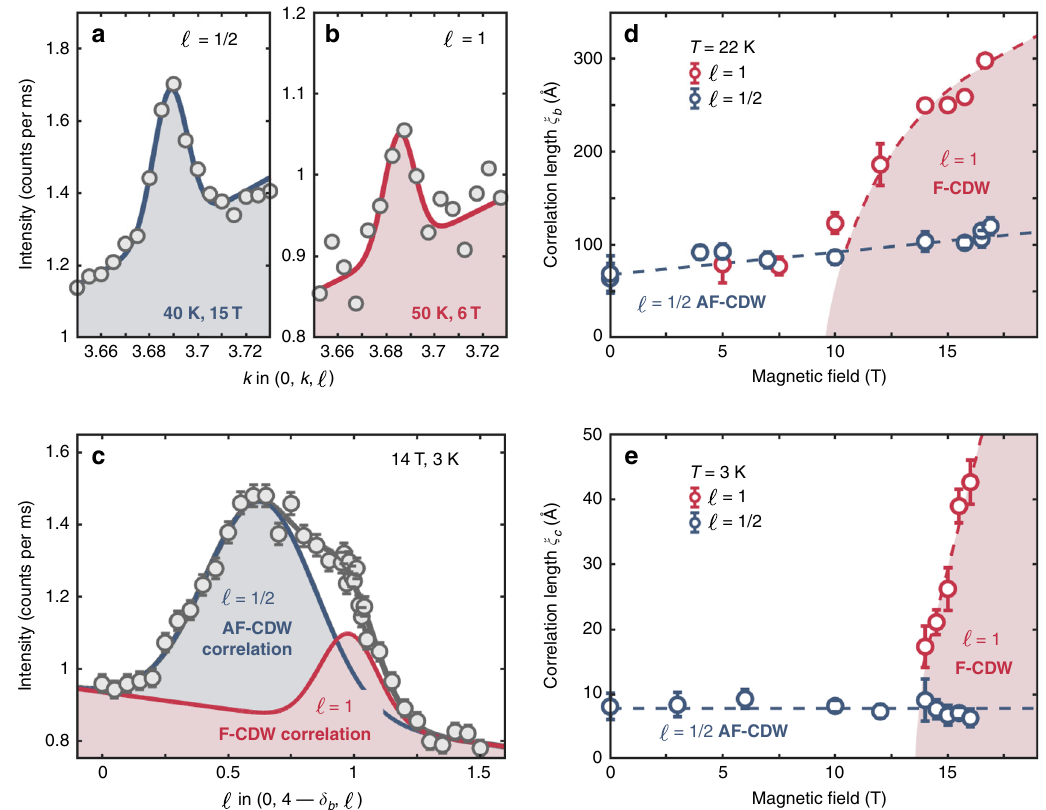
Fig. 3 Two-component analysis of out-of-plane charge-density-wave (CDW) correlations. a , b Raw diffraction intensities along (0, k , 1 ∕ 2) and (0, k , 1) for temperatures and magnetic fi elds as indicated. c Raw diffraction intensity pro fi le along the (0, 4 − δ b , ℓ ) direction, fi tted with two Gaussian functions on a linear background. The dark grey line is their sum. d , e Magnetic- fi eld-dependent evolution of the respective correlation lengths for ℓ = 1 ∕ 2 and 1. The dashed lines and shaded area are guides to the eye. Error bars are standard deviations determined by counting statistics and Gaussian fi ts, respectively. Source data are provided as a Source Data fi le.